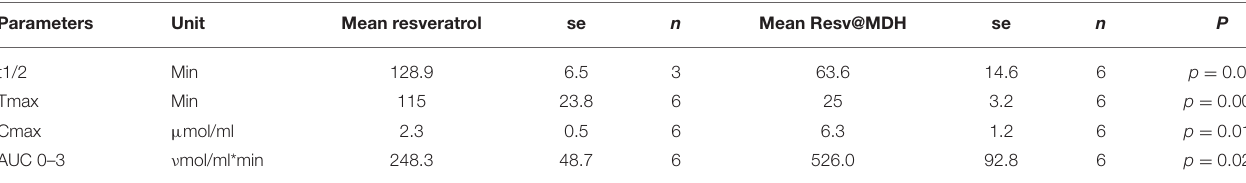
TABLE 2 | Summary of pharmacokinetic parameters for resveratrol following a single dose of 180mg resveratrol.